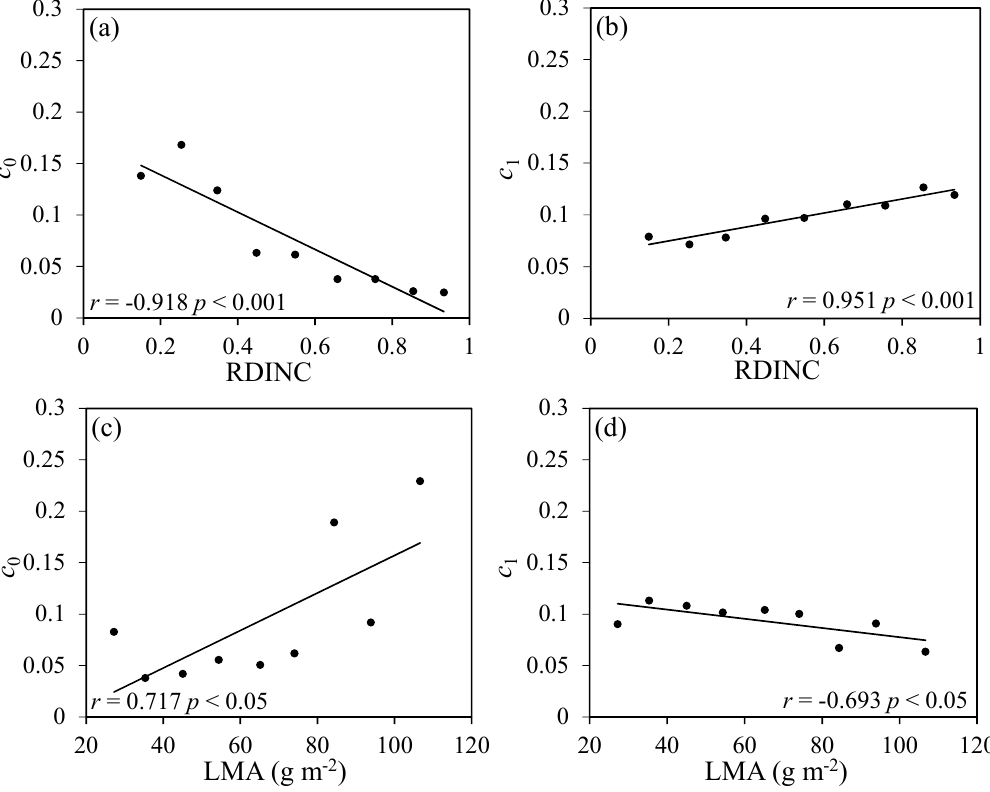
Figure 4. Relationships between the parameters ( c 0 and c 1 ) of Equation (4) and the relative depth into the crown (RDINC): ( a , b ) relationship of c 0 and c 1 versus RDINC; ( c , d ) relationship of c 0 and c 1 versus LMA (leaf mass per area). The r values are Pearson’s correlation coefficients. Solid lines are trend lines.